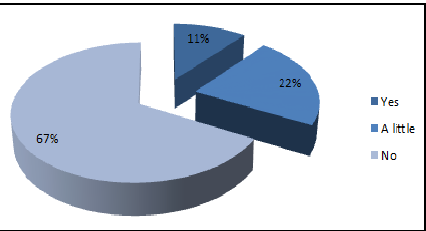
Figure. 2. The type of most shared publication